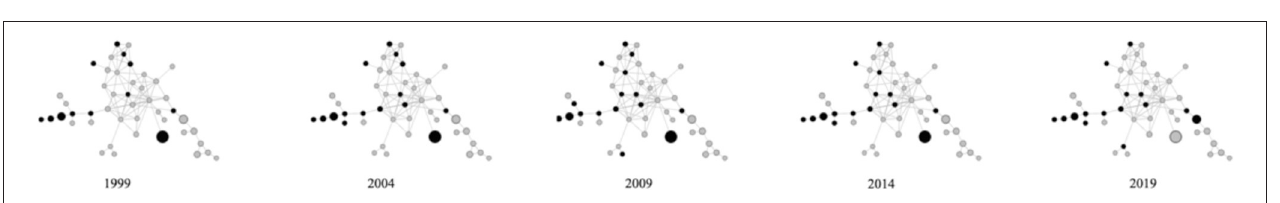
FIGURE 4 | Evolution of medical device product space in Japan.